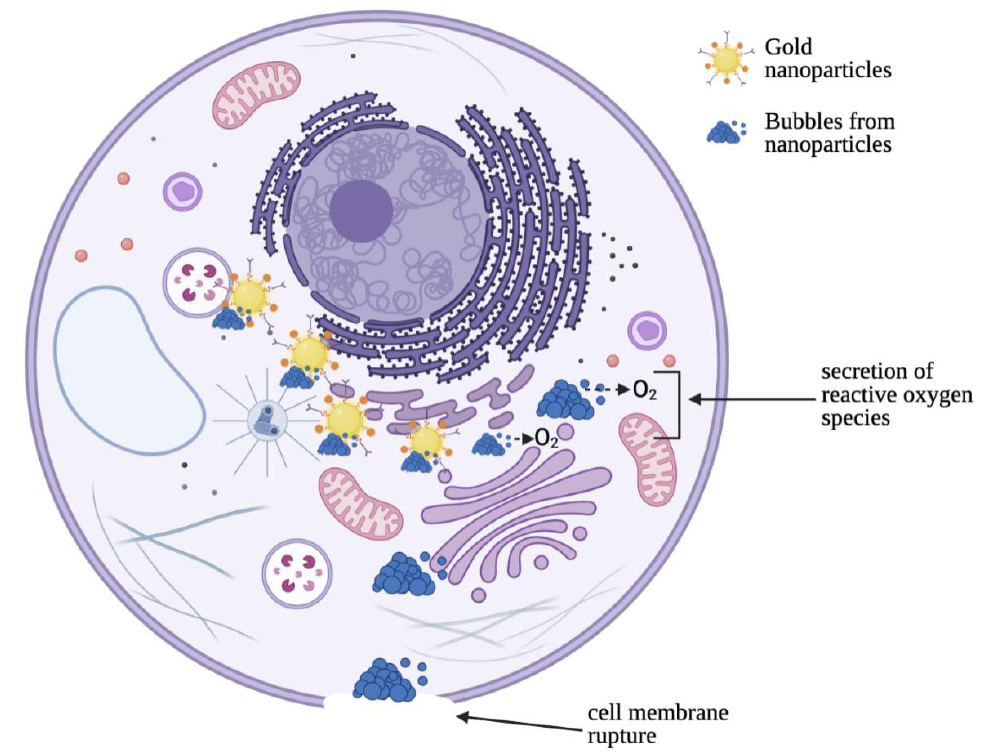
Figure 7. Schematic illustration of the cavitation effect in the eukaryotic cell, with a demonstration of ROS secretion and cell membrane rupture (created with BioRender.com).